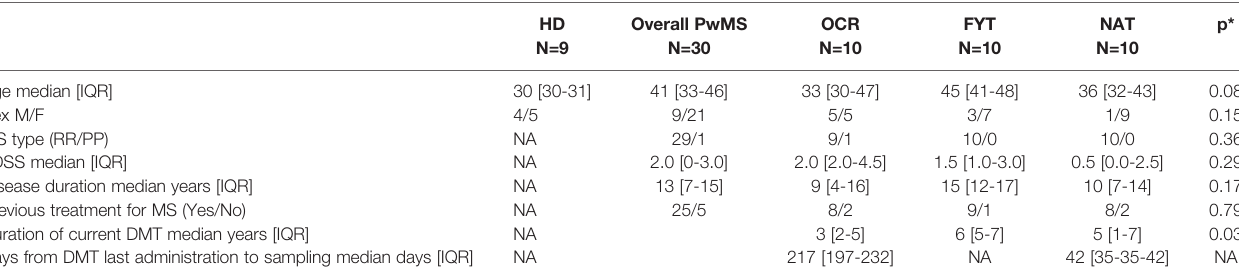
TABLE 1 | Demographic and clinical characteristics of PwMS and healthy